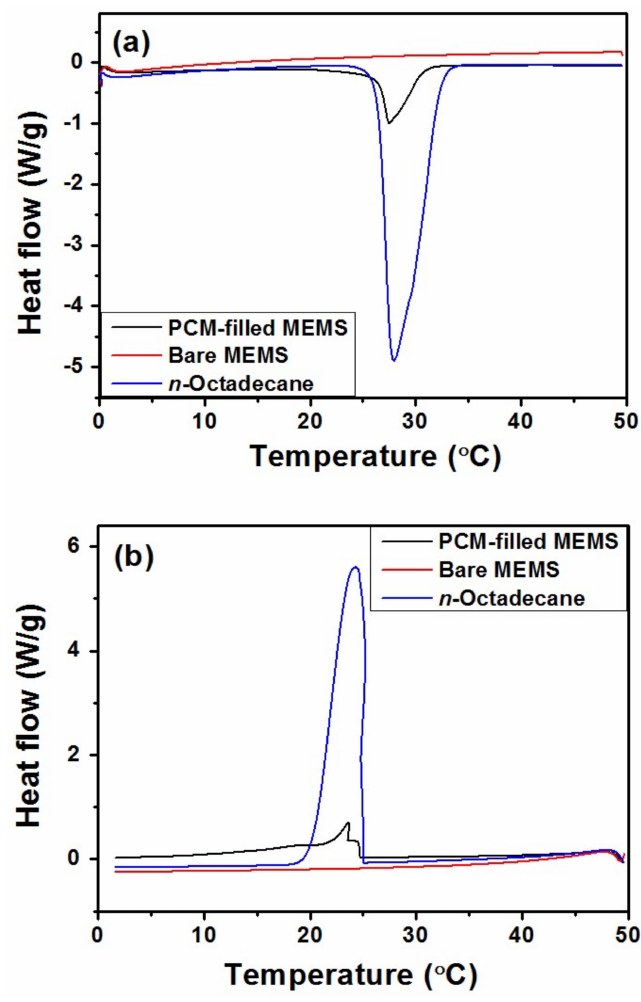
Figure 10. DSC curves of n -Octadecane, bare MEMS, and the n -Octadecane-filled MEMS during the ( a ) melting and ( b ) freezing